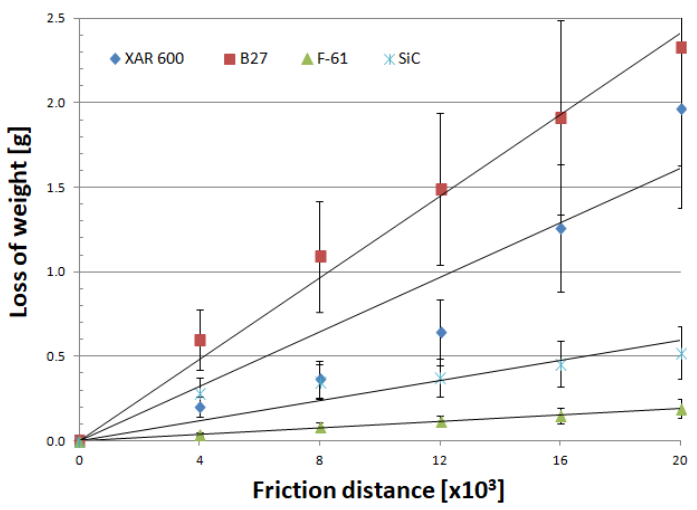
Figure 8. Mass wear as a function of friction distance for materials in medium soil.